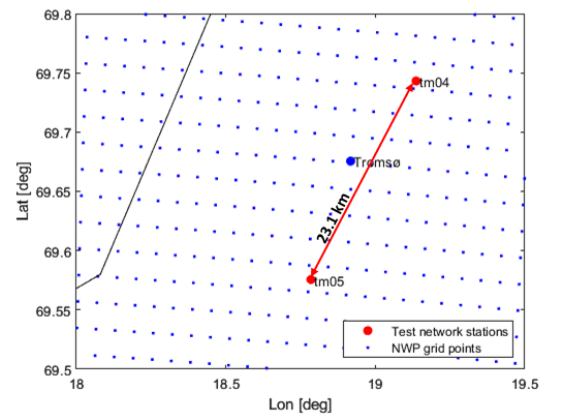
Figure 11. Locations of two GNSS stations and the baseline between them plotted in red; the NWP grid points are shown in blue. The black line is the